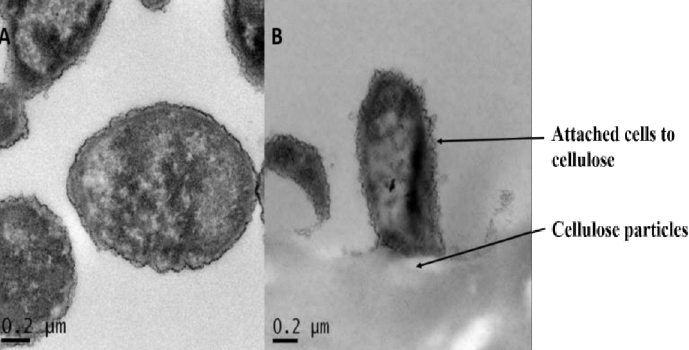
Fig 1. Transmission electron microscopy (TEM) images of the bacterium F . succinogenes S85 cells grown on glucose (A) and cellulose substrate